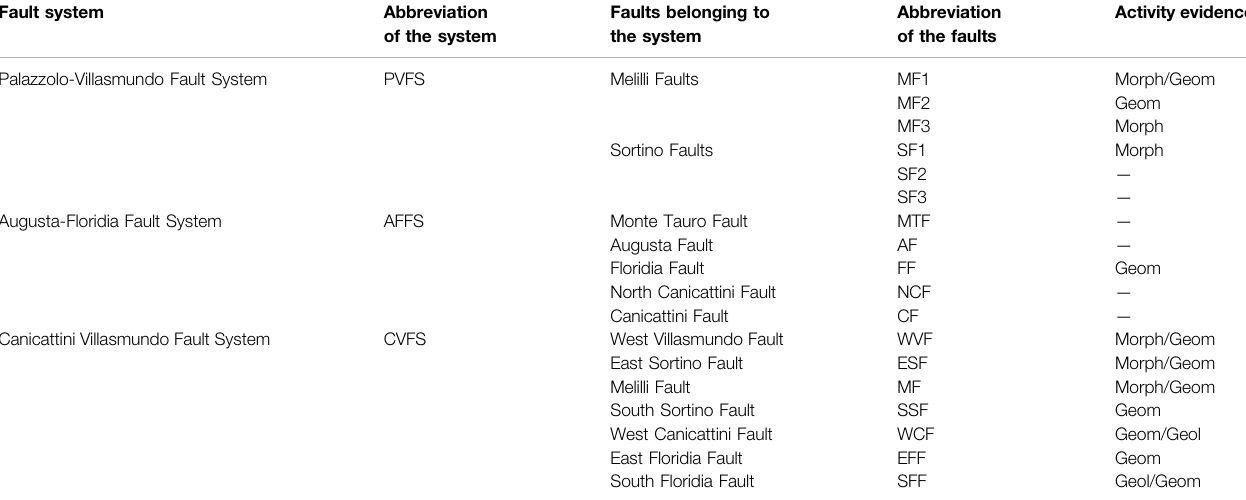
TABLE 2 | Fault abbreviations and activity observed by different kind of analyses: Geom, activity observed by geomorphological analysis; Morph, activity observed by morphometric analysis; Geol, activity observed by geological analysis. Fault